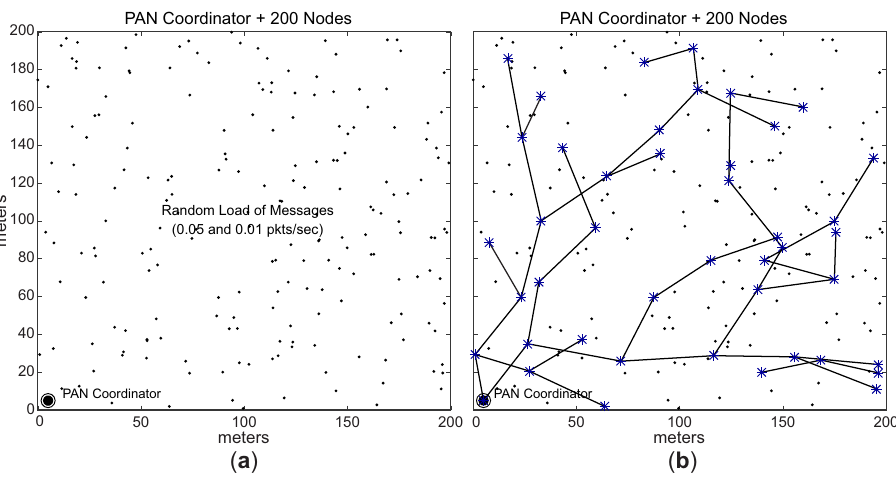
Figure 12. Configuration of the unconditioned Scenario : ( a ) Randomly distributed data rates; ( b ) Unconditioned cluster-tree network.